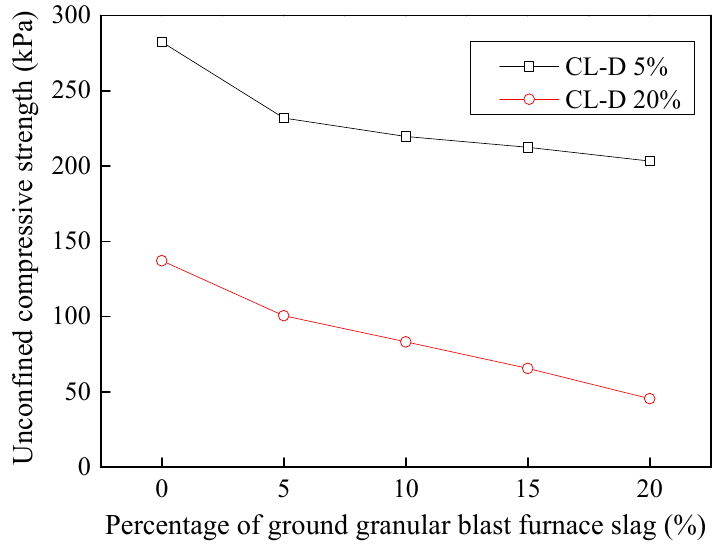
Figure 19. Improvement of dyeing effluent contaminated CL soil using GGBFS.